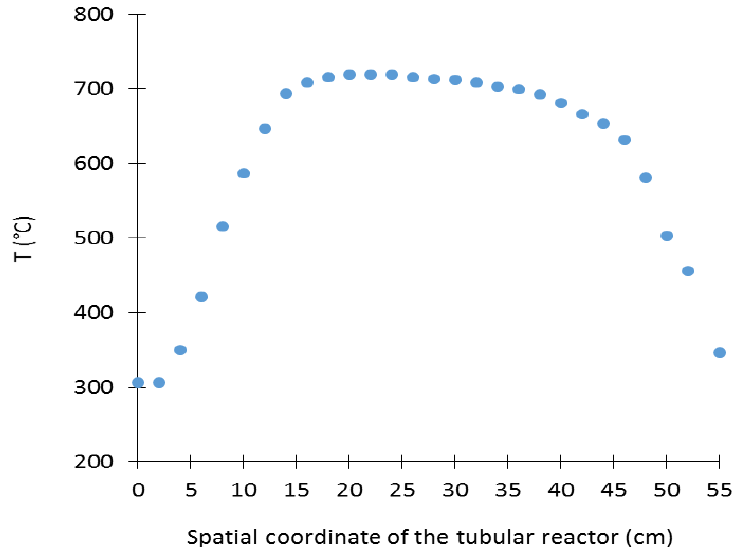
Figure 4. Temperature profile along the tubular reactor for a furnace set point temperature of 700 °C.